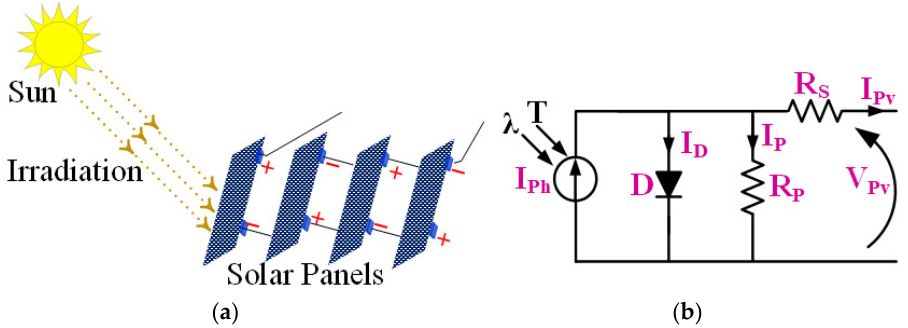
Figure 6. ( a ) Connection of solar panel and ( b ) equivalent circuit of solar panel.